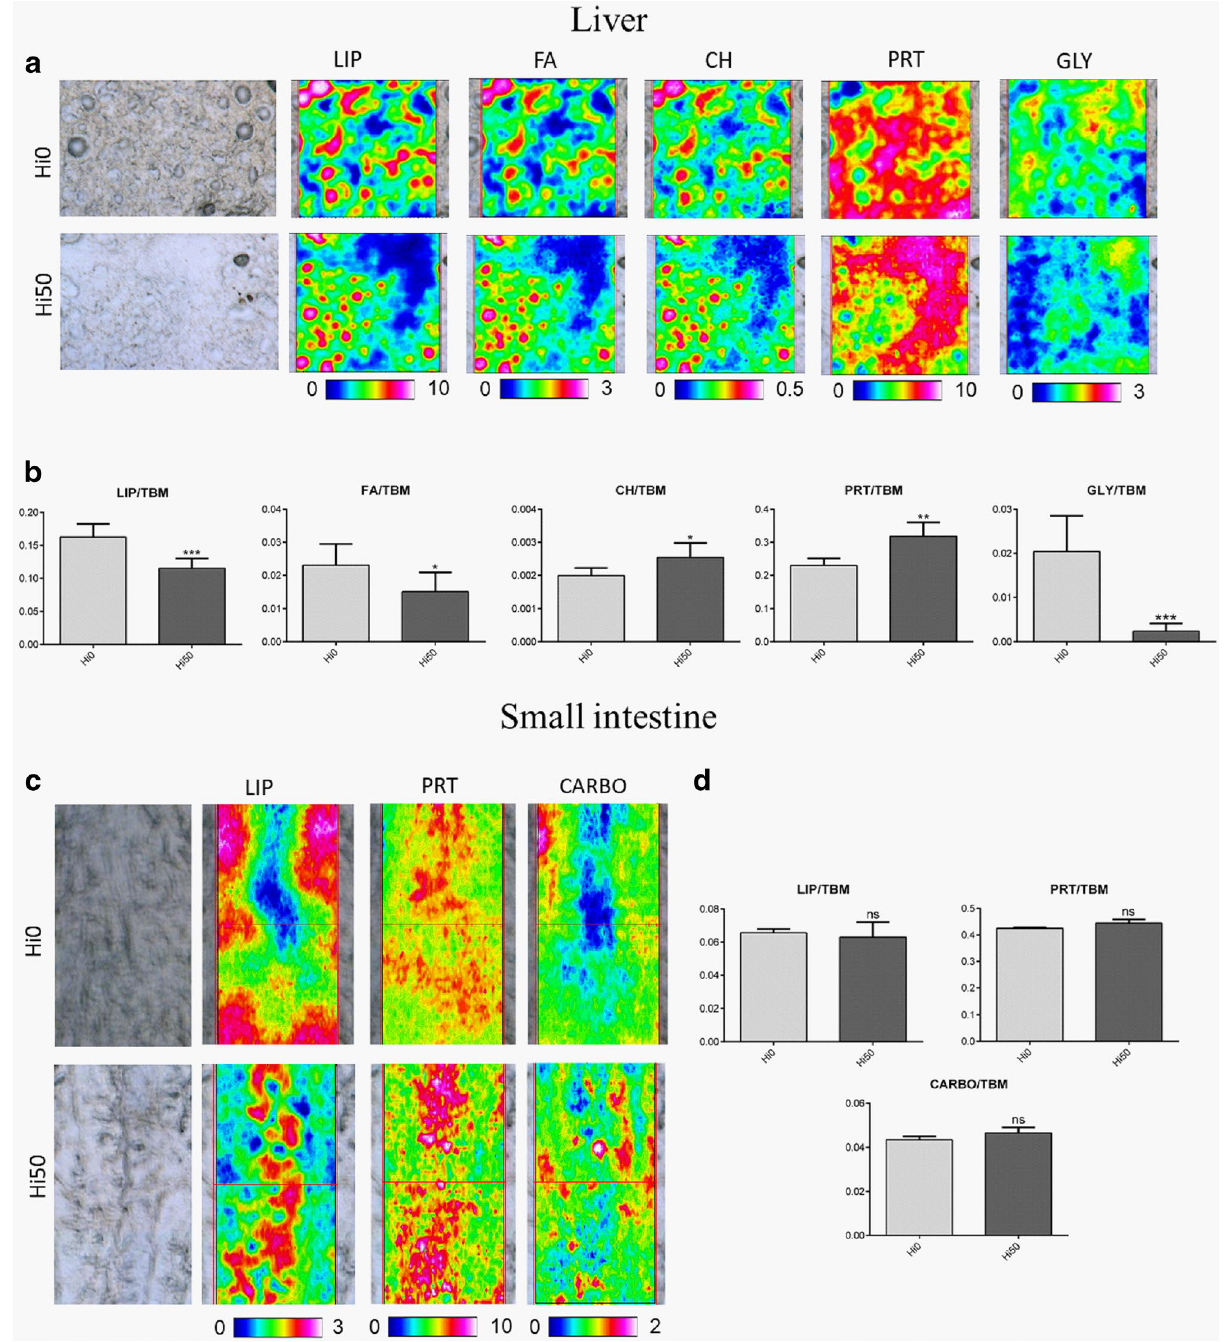
Figure 5. Spectral analysis of liver and small intestine samples of Siberian sturgeon collected at t 1 . ( a ) Microphotographs of liver samples and topographical distribution of: lipids (LIP maps), fatty acids (FA maps), unsaturated alkyl chains (CH maps), proteins (PRT maps), and glycogen (GLY maps) (map size 164 × 164 µm 2 ). ( b ) Statistical analysis of liver biochemical composition: LIP/TBM (relative amount of total lipids), FA/TBM (relative amount of fatty acids), CH/TBM (degree of unsaturation in lipid alkyl chains), PRT/TBM (relative amount of total proteins) and GLY/TBM (relative amounts of glycogen). ( c ) Microphotographs of small intestine samples and topographical distribution of: lipids (LIP maps), proteins (PRT maps) and carbohydrates (CARBO maps) (map size 328 × 164 µm 2 ). ( d ) Statistical analysis of small intestine biochemical composition: LIP/TBM (relative amount of total lipids), PRT/TBM (relative amount of total proteins) and CARBO/TBM (relative amount of carbohydrates). Significant differences between Hi0 and Hi50 are indicated as follows: ns non-significant; *p < 0.05; **p < 0.01; ***p < 0.001 and ****p < 0.0001. Data are reported as mean ± SD (n = 6). Sturgeons fed diets including 0 and 50 of BSF meal (Hi0 and Hi50,